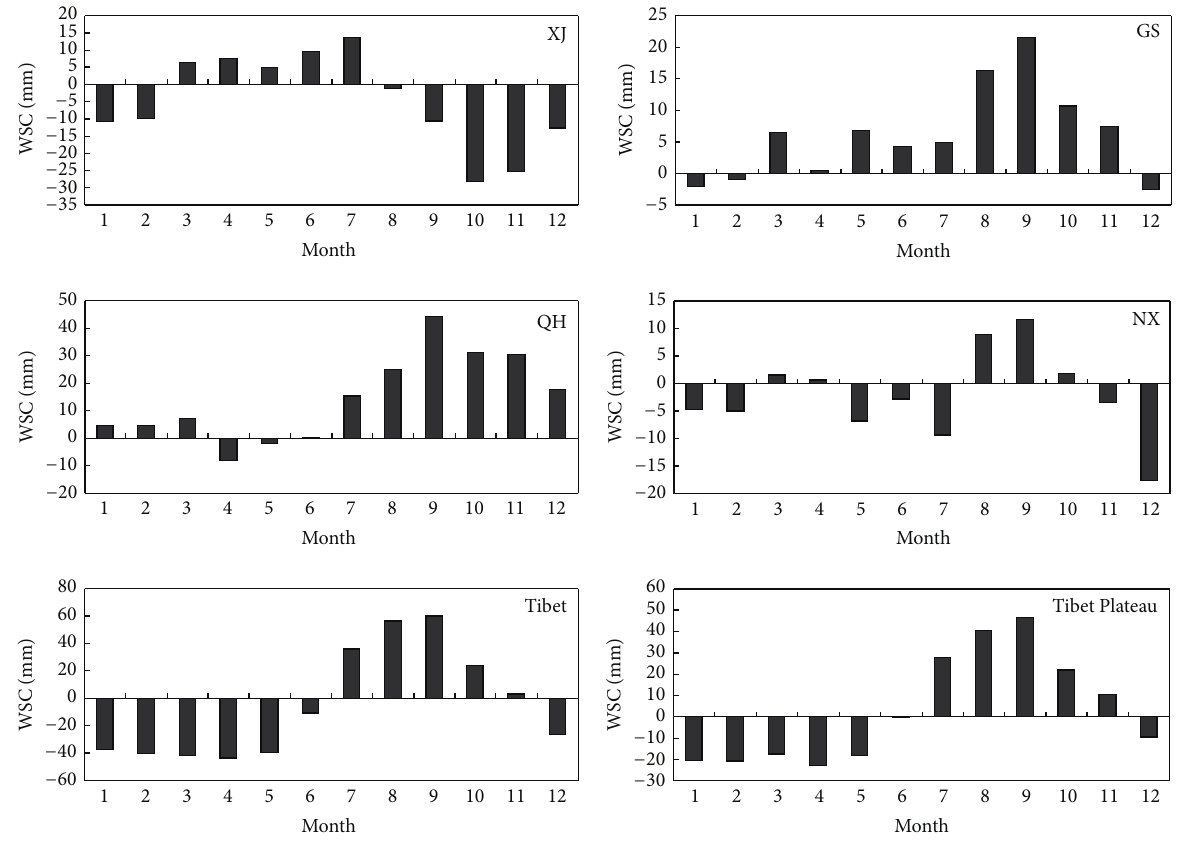
Figure 7: Annual distributions of WSC from 2003 to 2010.